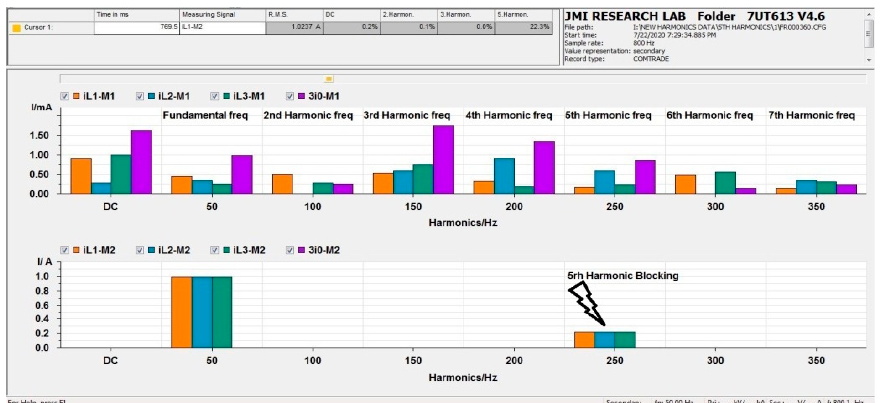
Figure 24. 5th HB at 1000 mA Rated current & 36% of Inrush current condition.